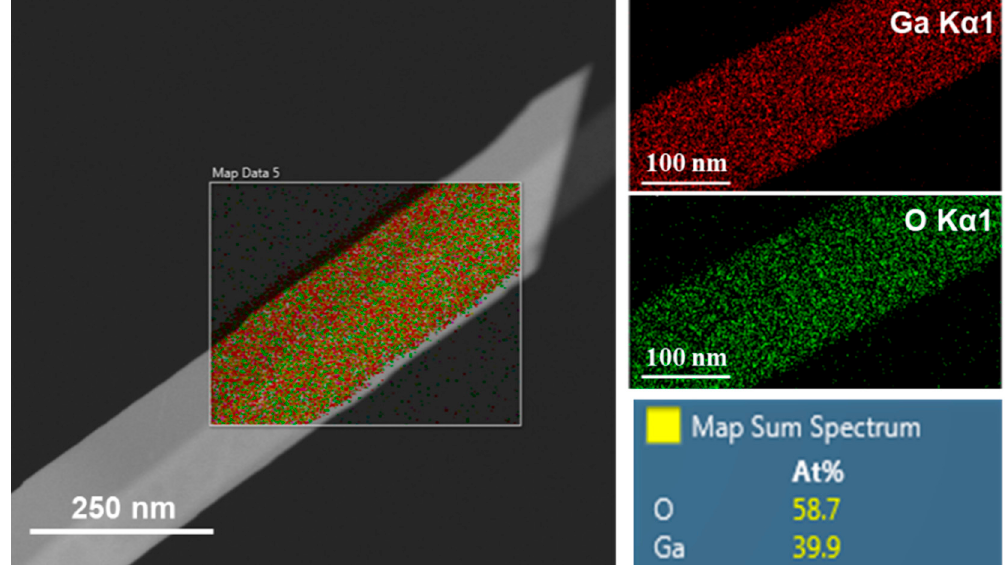
Figure 8. HRTEM image and the corresponding EDS mapping of Ga, O, Ag, and Si of Ga 2 O 3 nanowire on (100) silicon substrate in the presence of Ag catalyst. A single Ga 2 O 3 nanowire was observed. Unintentional silicon atoms in Ga 2 O 3 nanowires could increase the background impurity.